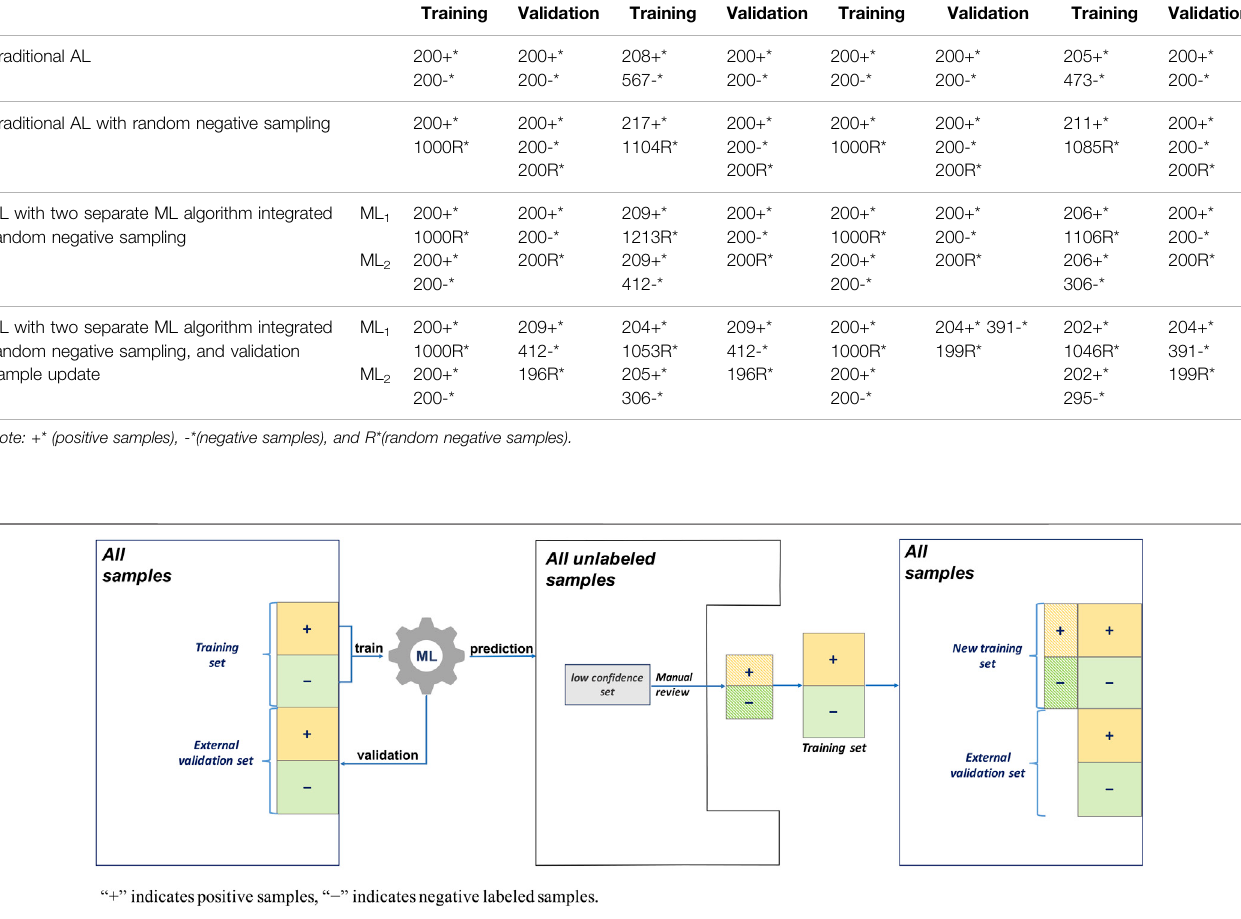
FIGURE 3 | Active learning work fl ow with a single machine learning (ML) algorithm, uncertainty sampling, and no validation update.